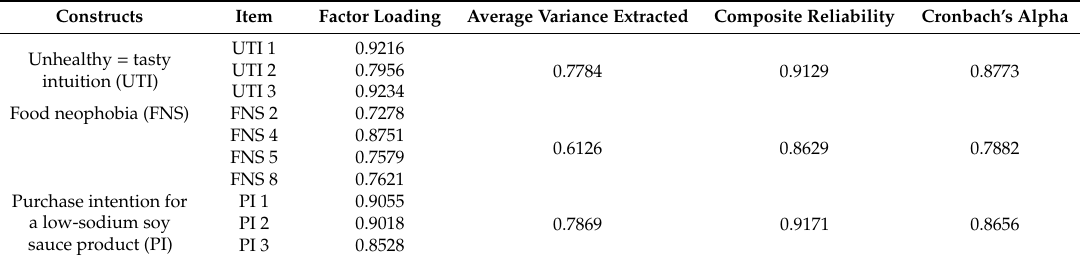
Table 5. Reliability and validity values from the second experiment: yogurt products.